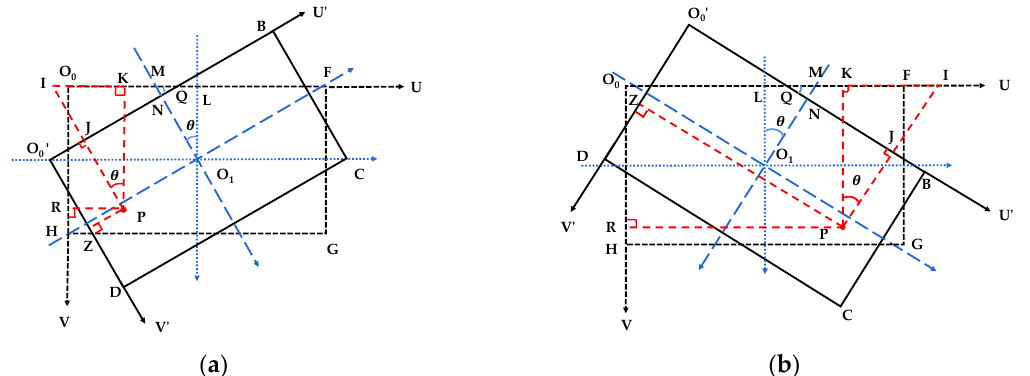
Figure 6. Schematic diagram of the image plane of the camera rotating around the optical axis. ( a ) Rotate counterclockwise; ( b ) Rotate clockwise.